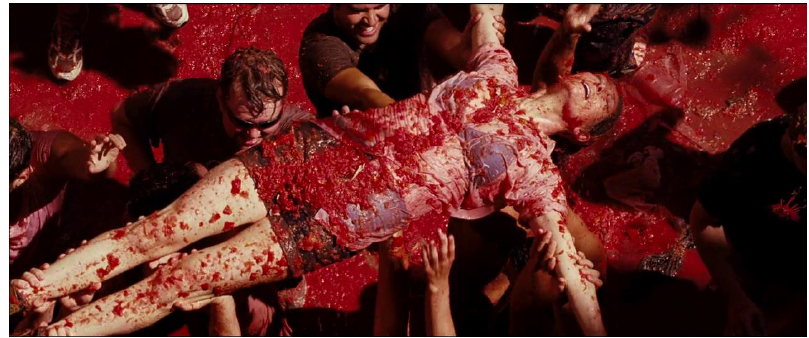
Figure 1. The White Curtain.